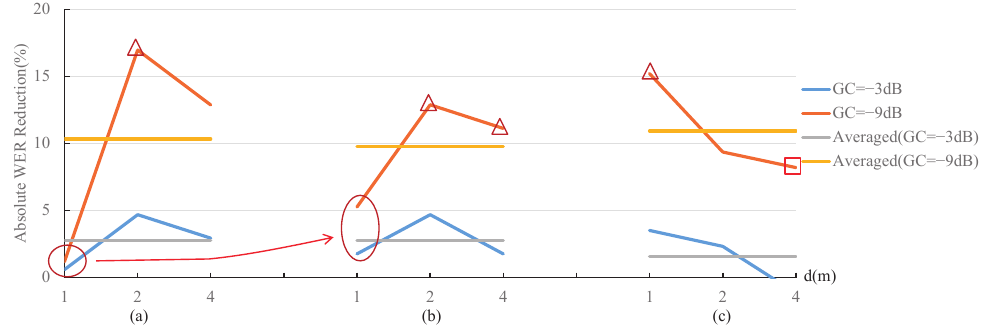
Figure 11. Absolute WER reduction under different RT60 and speaker-microphone distance condi- tions. ( a ) RT60 = 0.5 s. ( b ) RT60 = 0.7 s. ( c ) RT60 = 1